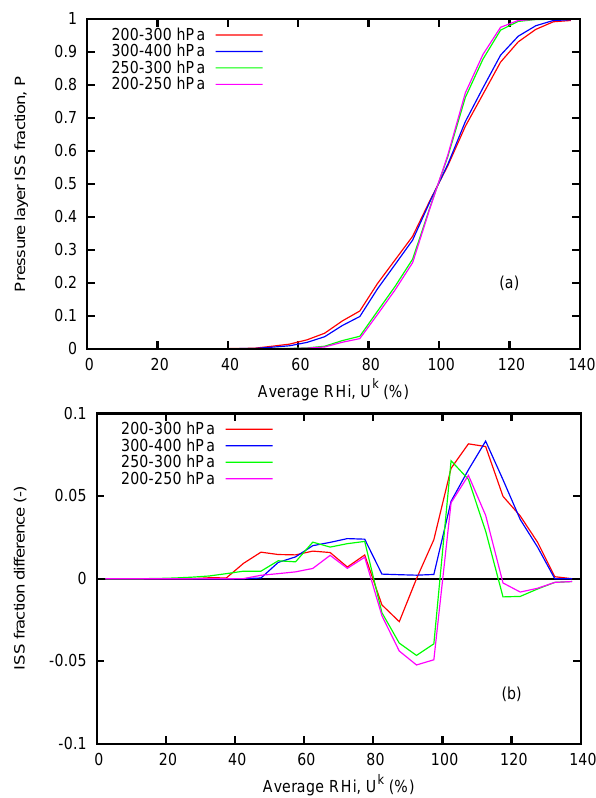
Fig. 15. S-shaped curves constructed using an error function representation for F u (100) with the standard deviations from Fig. 14 are shown in panel (a) for two 50- and two 100-hPa pressure layers. Panel (b) displays the differences between the modelled curves and the average derived from the British Isles dataset (January 2002–December 2006).